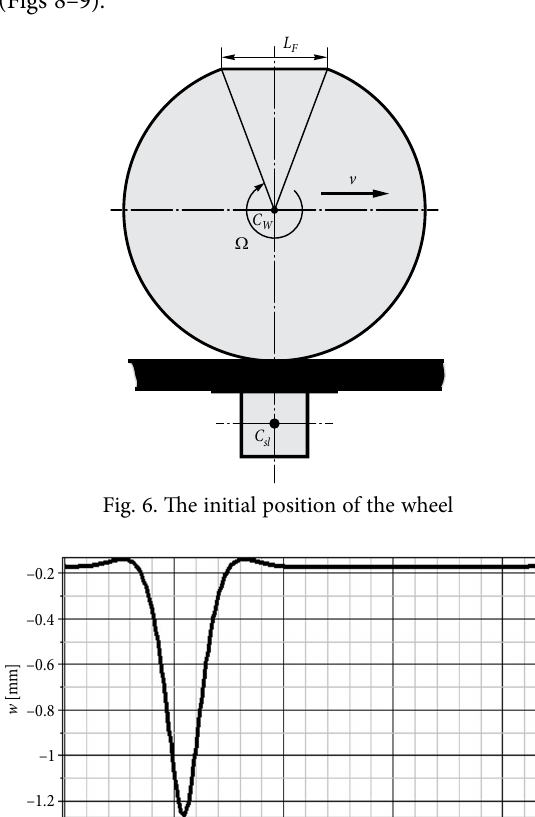
Fig. 8. Changes in the effective rolling radius of the rotating wheel flat: a – defined under the time from 0 to 0.6 s; b – defined under the time from 0.277 to 0.283 s